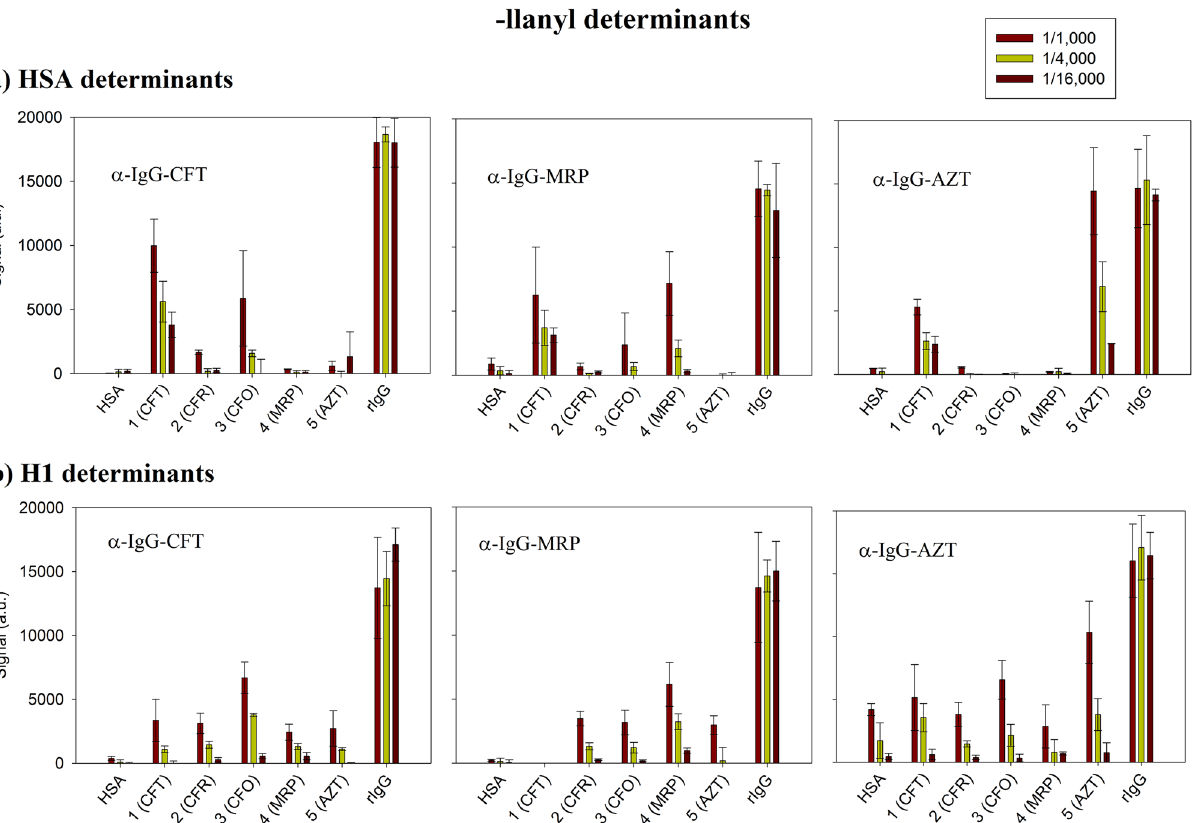
Figure 7. Signals obtained for the -llanyl determinants with polyclonal rabbit IgG. Dilution factors: 1/1000, 1/4000 and 1/16,000). ( a ) HSA determinants; ( b ) H1